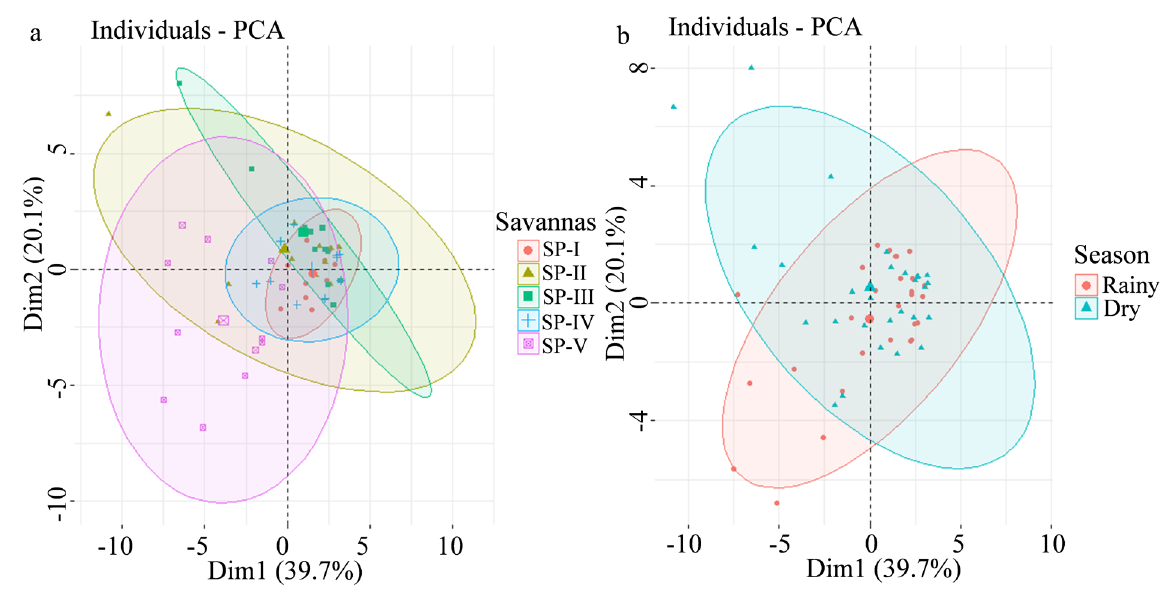
Figure 2. Principal Component Analysis of bryophytes of the Marajó Island, Pará. (a) Sampled savanna áreas; (b)